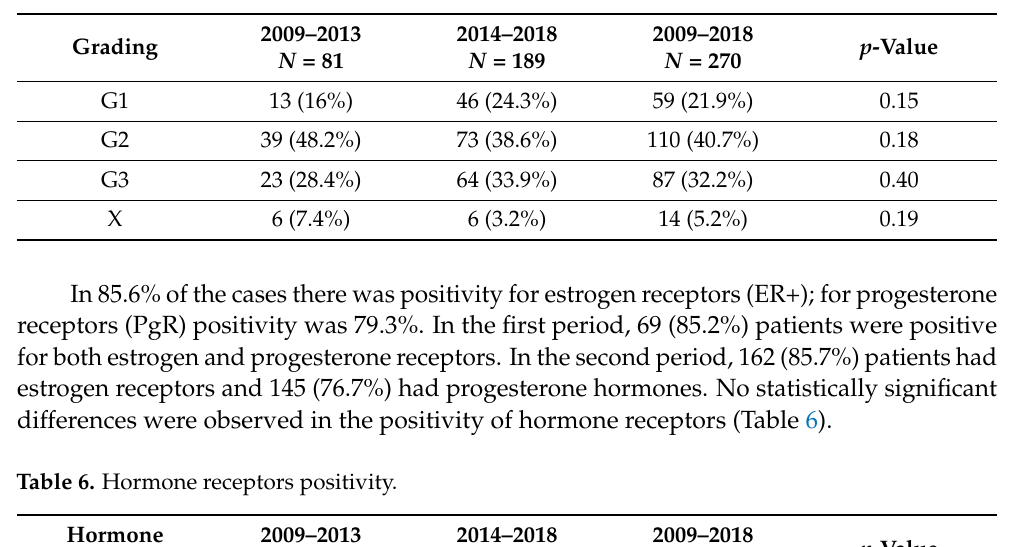
Table 5. Subdivision by histological degrees of the surgical specimens.